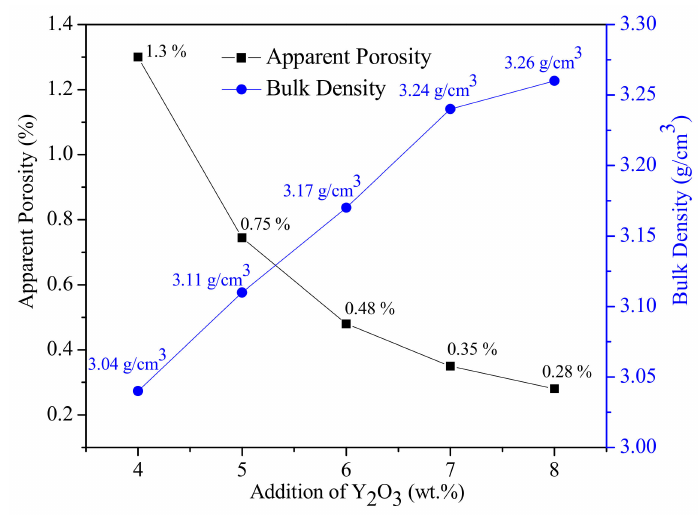
Figure 1. Apparent porosity and bulk density of 50 wt. %SiC-40 wt. %AlN multiphase ceramics with